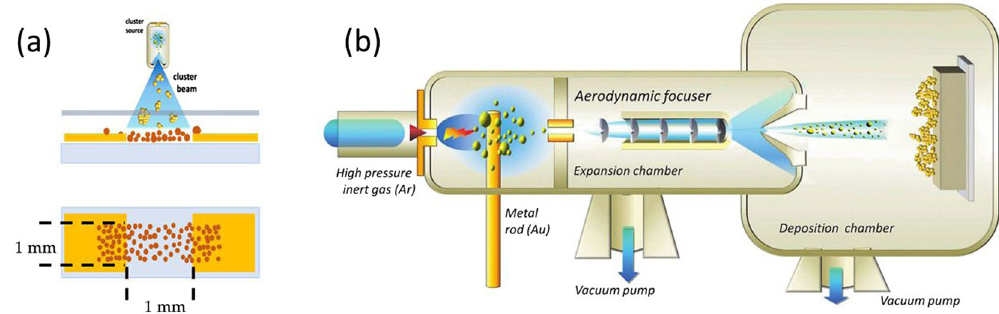
Figure 4. Device fabrication with Supersonic Cluster Beam Deposition. ( a ) Schematic of the cluster-assembled film fabrication. ( b ) Schematic representation of the SCBD apparatus (not to